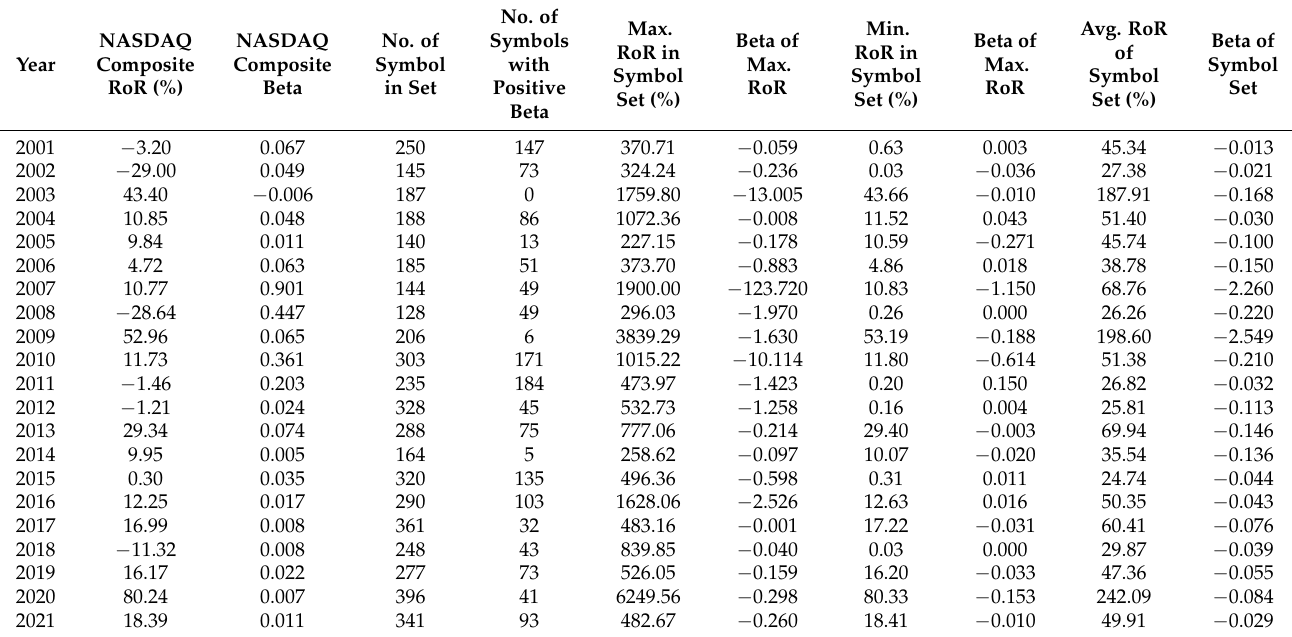
Table 2. Sets of NASDAQ stocks, selected annually, based on the rate of return (RoR) of the NASDAQ Composite index and its beta relative to the CSIE of the market as a